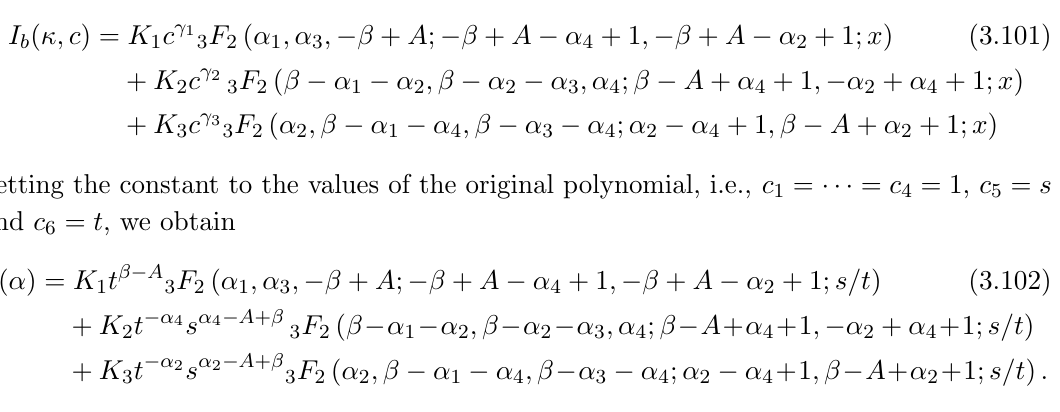
, s 2 = (cid:0) p 2 , s 3 = (cid:0) ( p 1 + p 2 ) 2 1 2